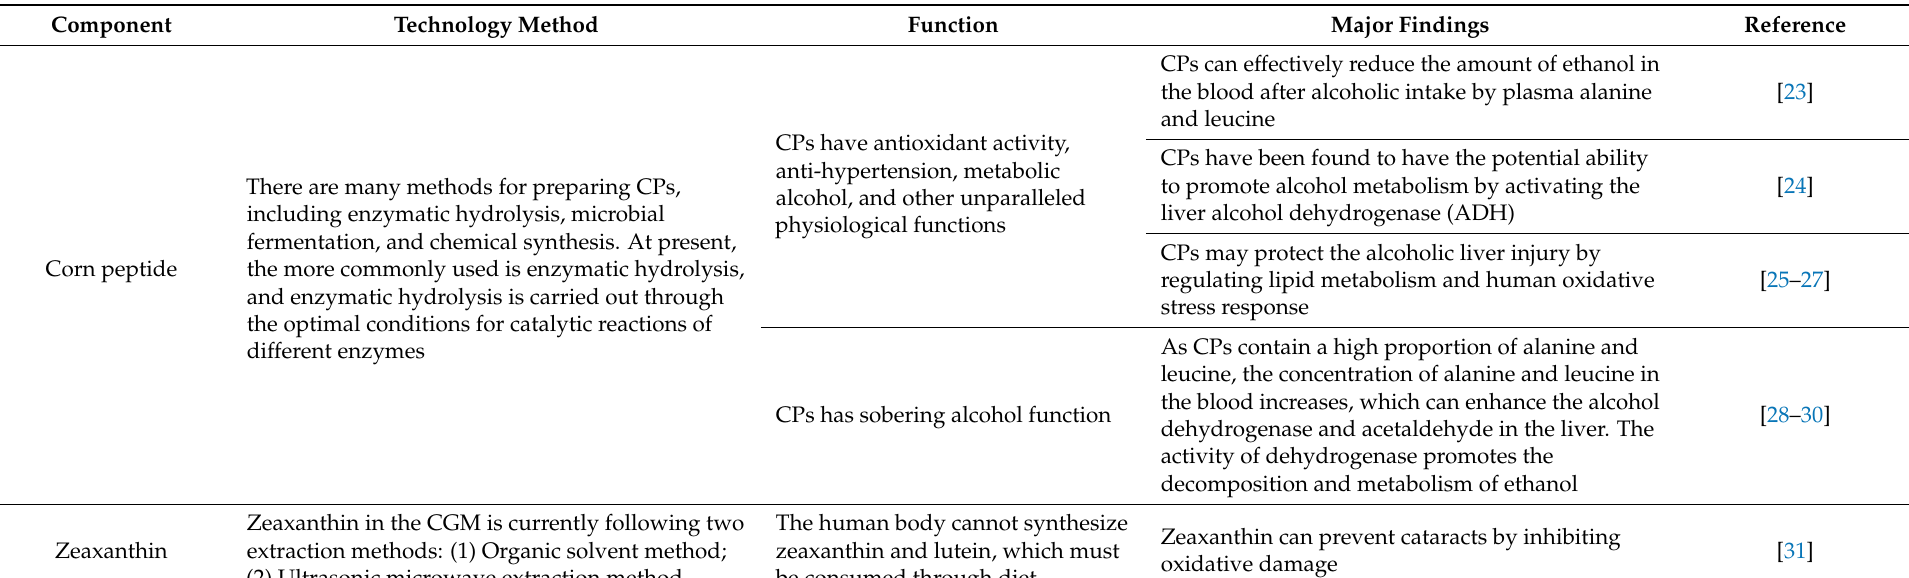
Table 1. The main component, technology method, function, and major findings of corn gluten